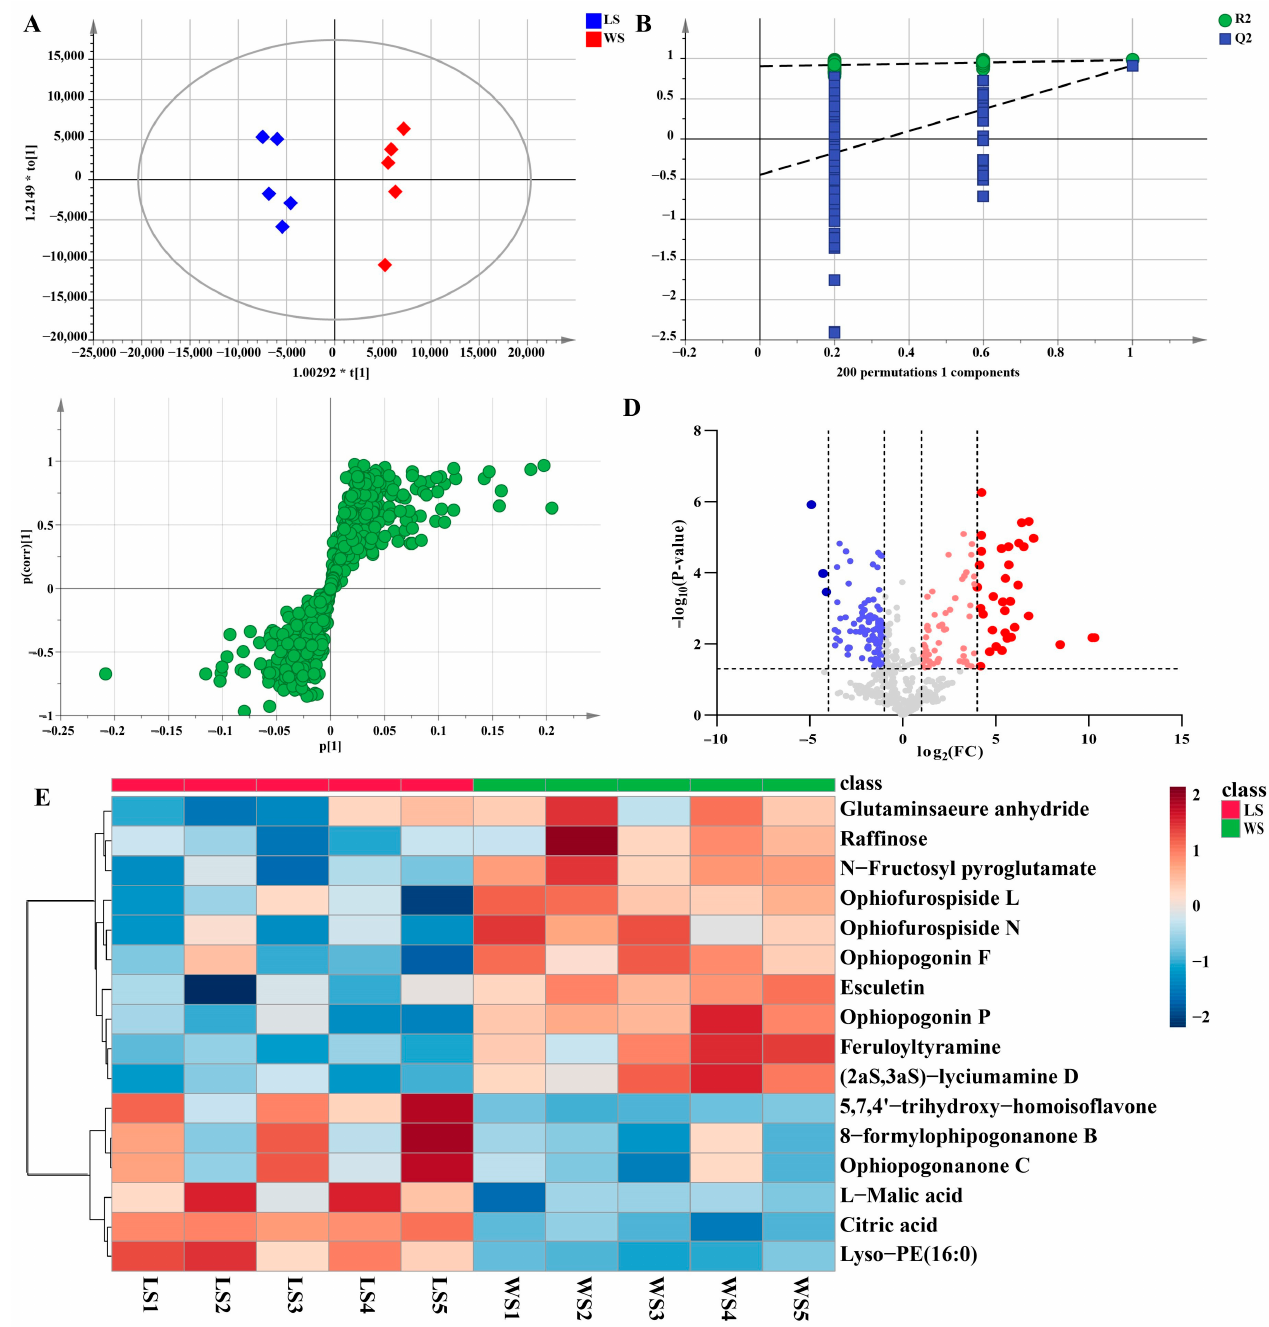
Figure 8. Multivariate statistical analysis result of LS and WS groups: OPLS-DA ( A ) score plots and OPLS-DA model permutation test ( B ), S-plot ( C ) and Volcano plots ( D ), ( C , D ) were used to explore markers in LS and WS, the heatmap of potential chemical markers ( E ).